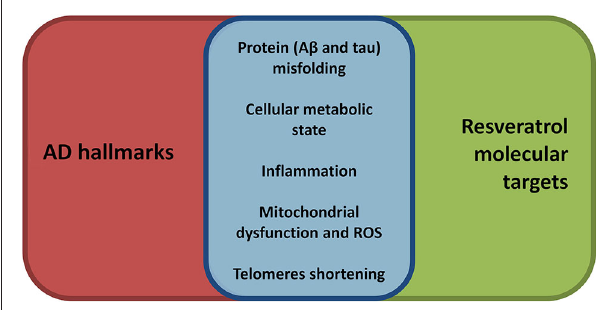
FIGURE 1 | Synoptic view of the overlap between aging, and thus AD, hallmarks (see López-Otín et al., 2013) and the molecular targets of resveratrol . Resveratrol, compared to many other disease modifying approaches, shows a broader range of beneficial effects targeting many molecular aspects of AD pathogenesis. Thus, resveratrol may represent a promising broad-spectrum neuroprotective agent in